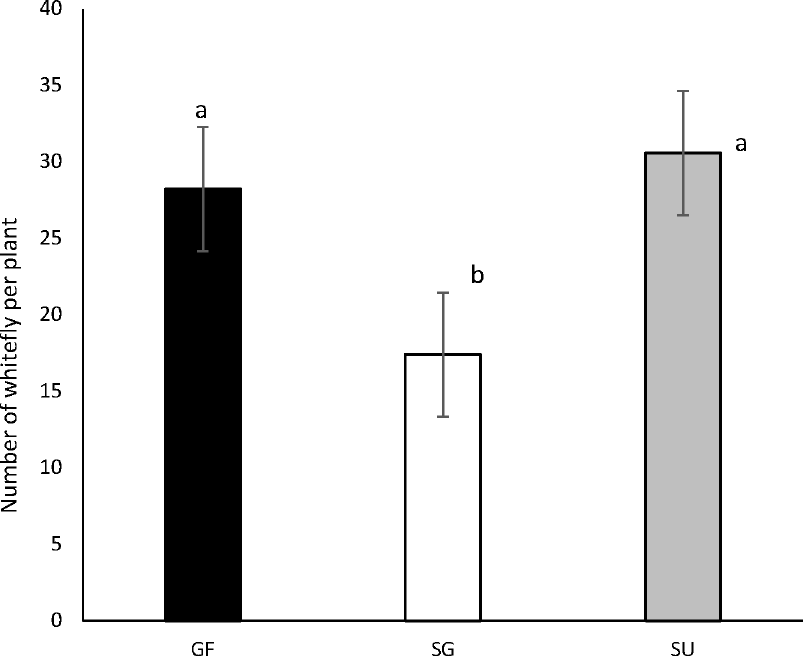
Fig 1. Average abundance of B . tabaci adults recorded on the top five leavesof 30 plants from sites in each of the main agro-ecological zones of Central African Republic. Vertical lines represent 95% confidenceintervals, whilst means followedby the same letter are not significantly different (Generalized Tukey’s all pairwisecomparisons test at P < 0.05). GF—Guinean Forest Zone; SG—Sudano-Guinean Zone; and SU—Sudano Ubanguian